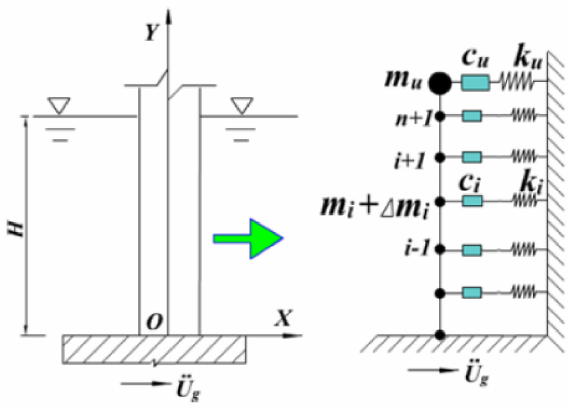
Figure 2. FSI based on the added mass ratio method.